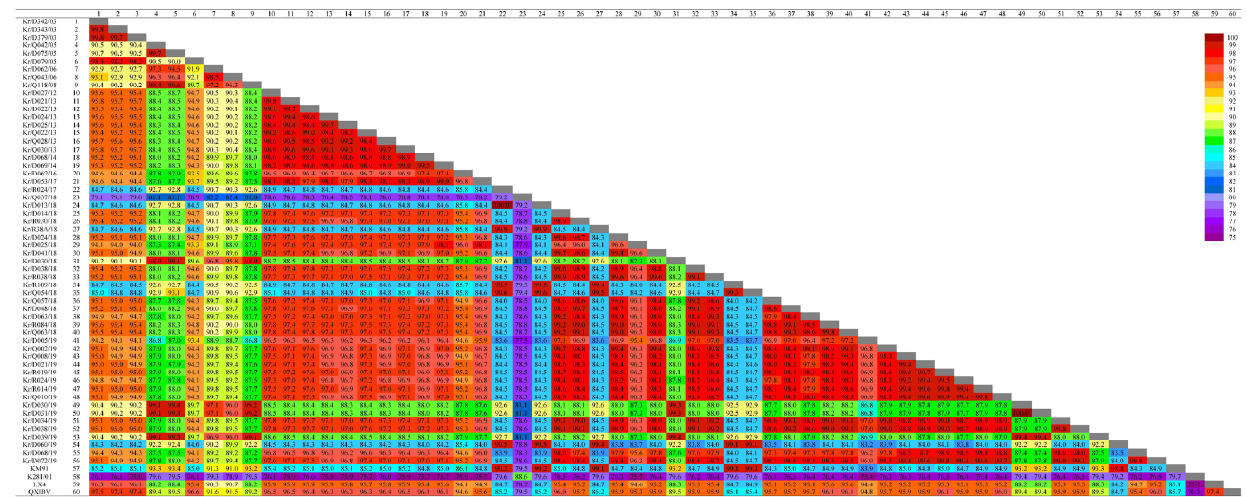
Figure 2. Percentage identity matrix of the nucleotide sequences of 56 isolates and 4 reference strains of IBV. The color-coded pairwise identity matrix was generated from the S1 genes of 60 IBVs. Each colored cell represents the percentage identity score between two sequences (indicated horizontally to the right). The color key indicates the degree of correspondence between pairwise identities and the colors displayed in the matrix.